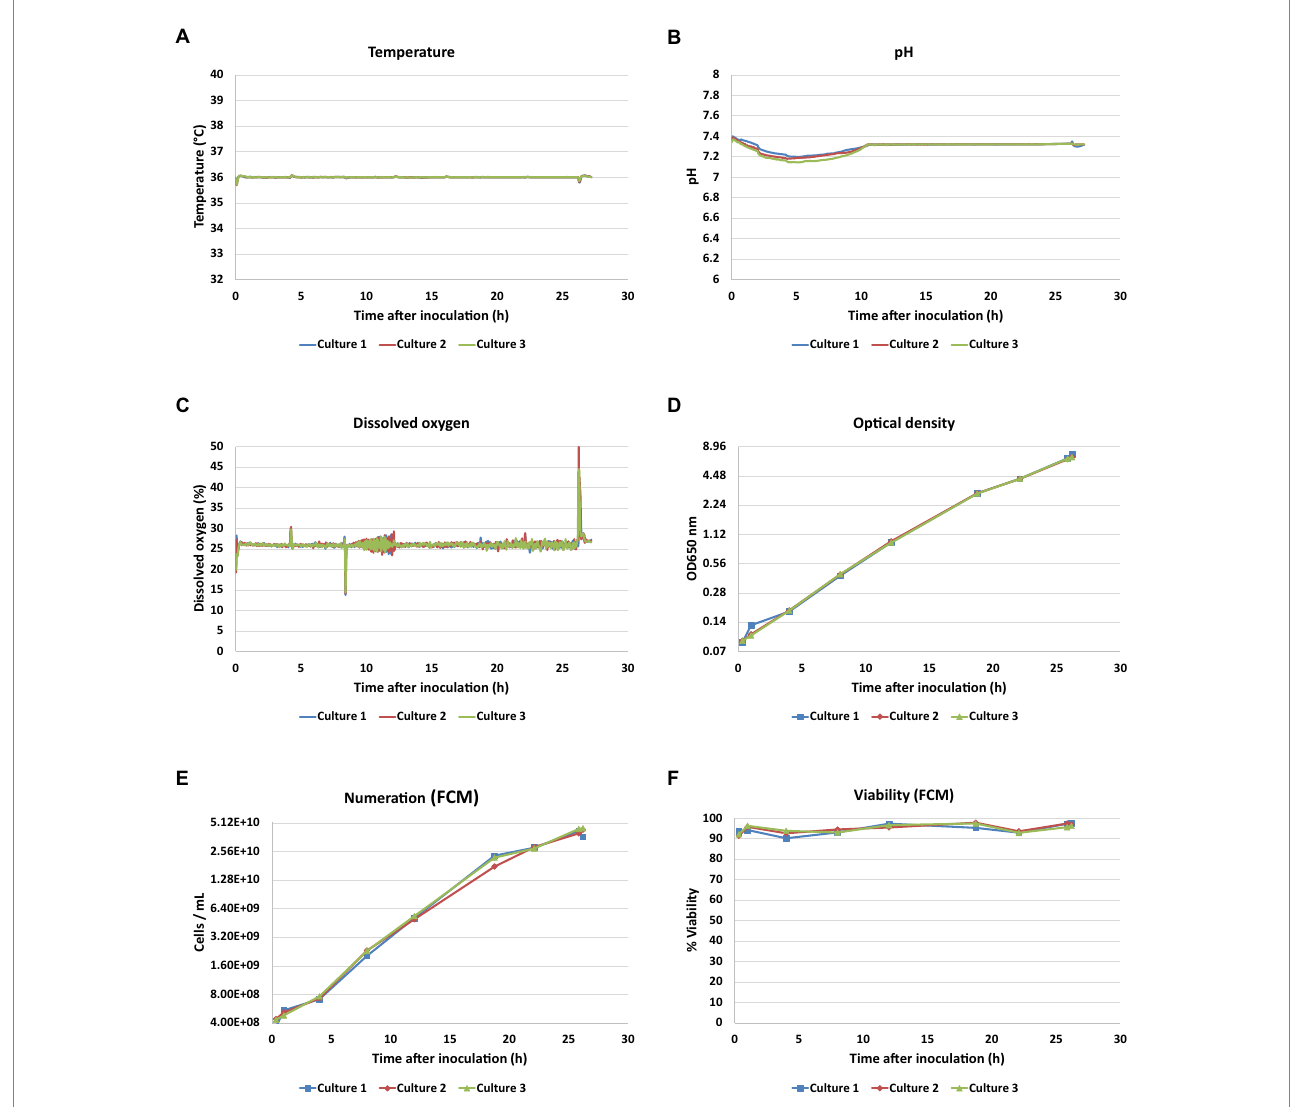
FIGURE 2 Monitoring profiles of three independent bioreactor cultures of Bordetella pertussis Tohama I. Temperature (A) , pH (B) , DO (C) were monitored inline by Ambr system, OD 650 (D) , bacteria numeration by flow cytometry (E) , and viability measured by flow cytometry (F) were offline determined on 8 time